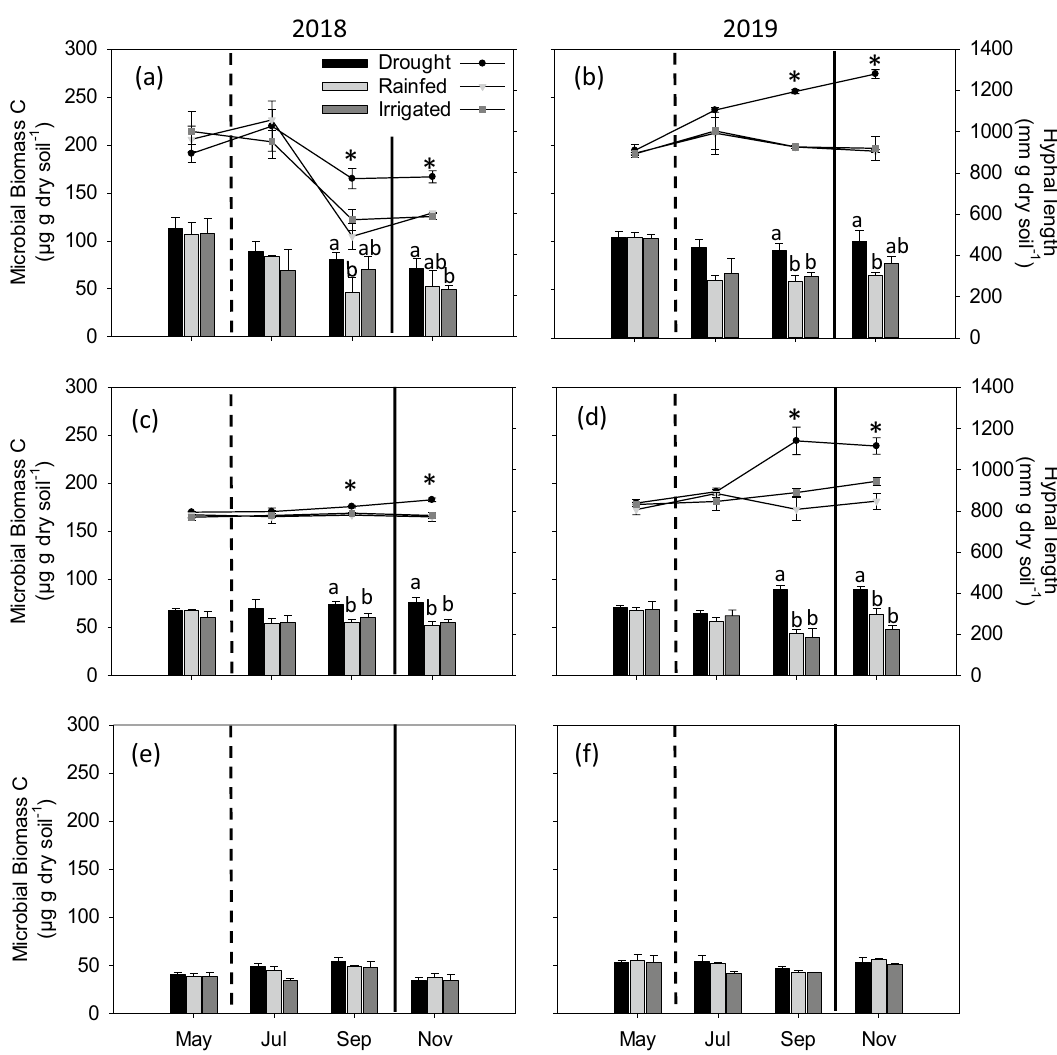
Figure 5. Microbial biomass carbon concentrations (bar graphs) under drought, rainfed, and irrigated treatments at 0–5 ( a , b ), 5–15 ( c , d ) and 15–30 ( e , f ) cm depths during 2018 and 2019. Different letters represent statistical significance at p ≤ 0.05 at each time point. No letters mean no statistical significance. The secondary axis represents the hyphal length (line graph) in each treatment at each time point. The hyphal length was not determined for 15–30 cm depth ( e , f ) as microbial biomass carbon did not show significant differences between treatments. Asterisk represents statistical significance at p ≤ 0.05 at each time point. Error bars represent standard error (n = 3). Sampling in May represents baseline and in November represents post shelter removal. Vertical dashed line represents shelter establishment date and solid line represents shelter removal